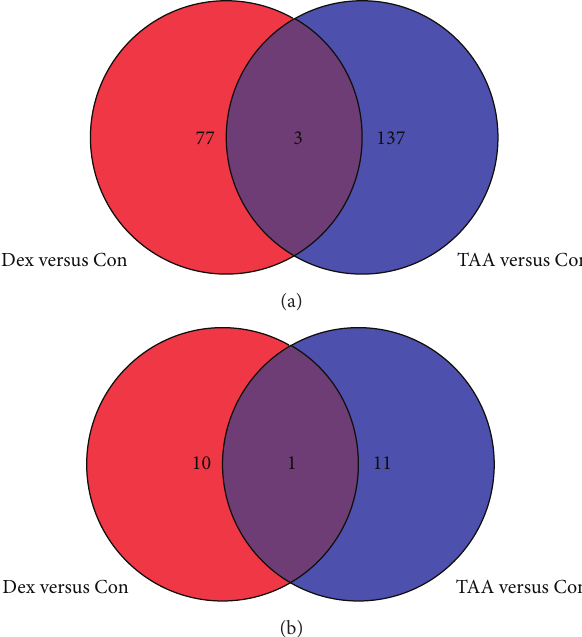
Figure 1: Venn diagram detailing the number of genes in each category. (a) One-week postinjection time point for fold change (FC) > 1.5, 𝑝 < 0.05 . (b) One-month postinjection time point for FC > 1.5, 𝑝 < 0.05